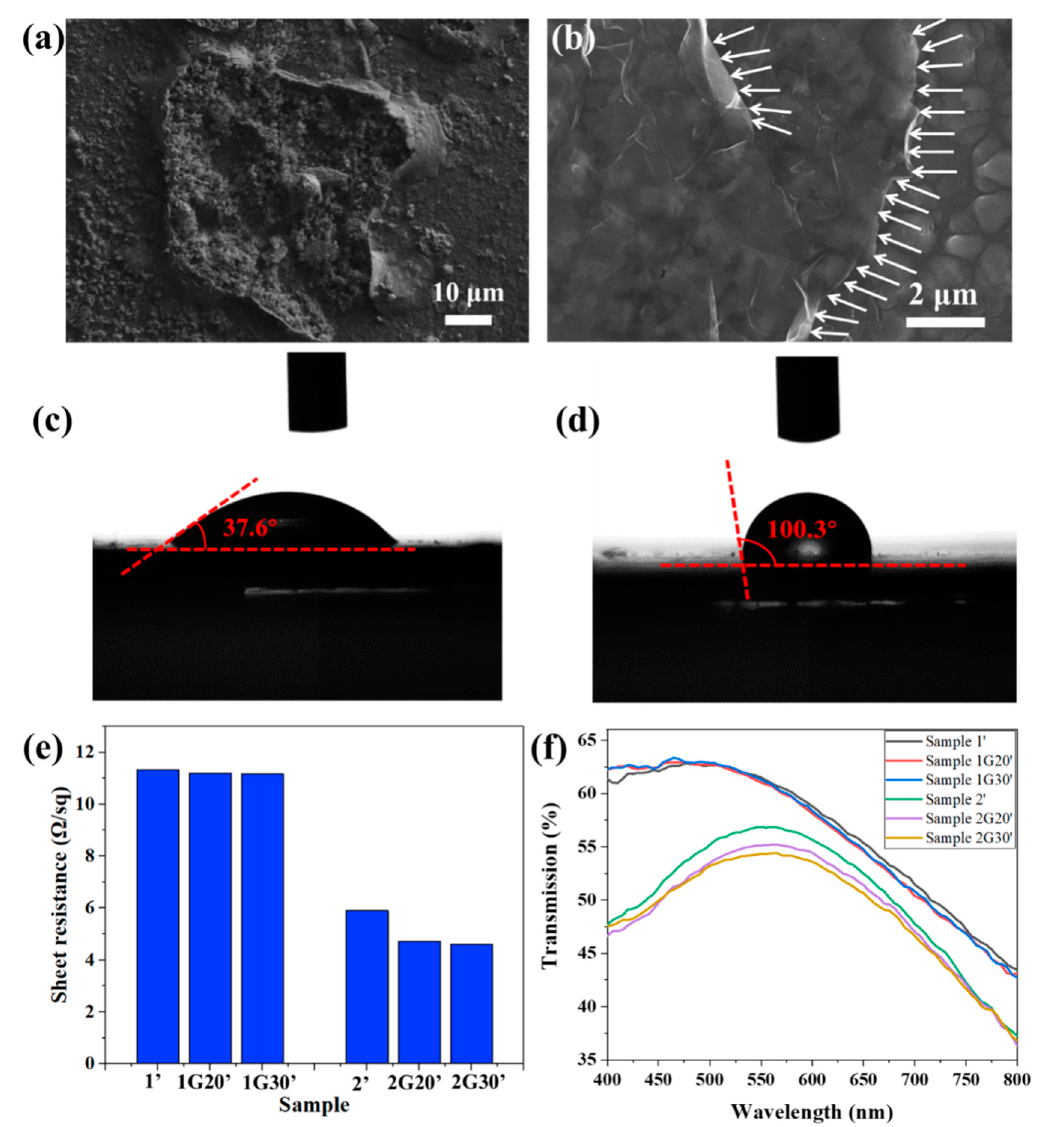
Figure 6. ( a , b ) SEM images of ACF ( a ) and G/ACF ( b ) samples after salt spray test. ( c , d ) Contact angles of the surface of ACF ( a ) and G/ACF ( b ) samples. ( e , f ) Surface resistance ( e ) and transmission ( f ) of ACF samples and G/ACF samples after 72 h salt spray test.